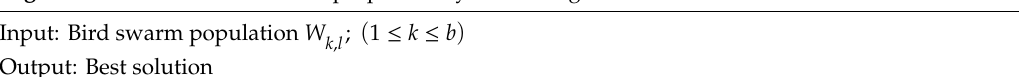
Algorithm 1. Pseudocode for the proposed Taylor-BSA